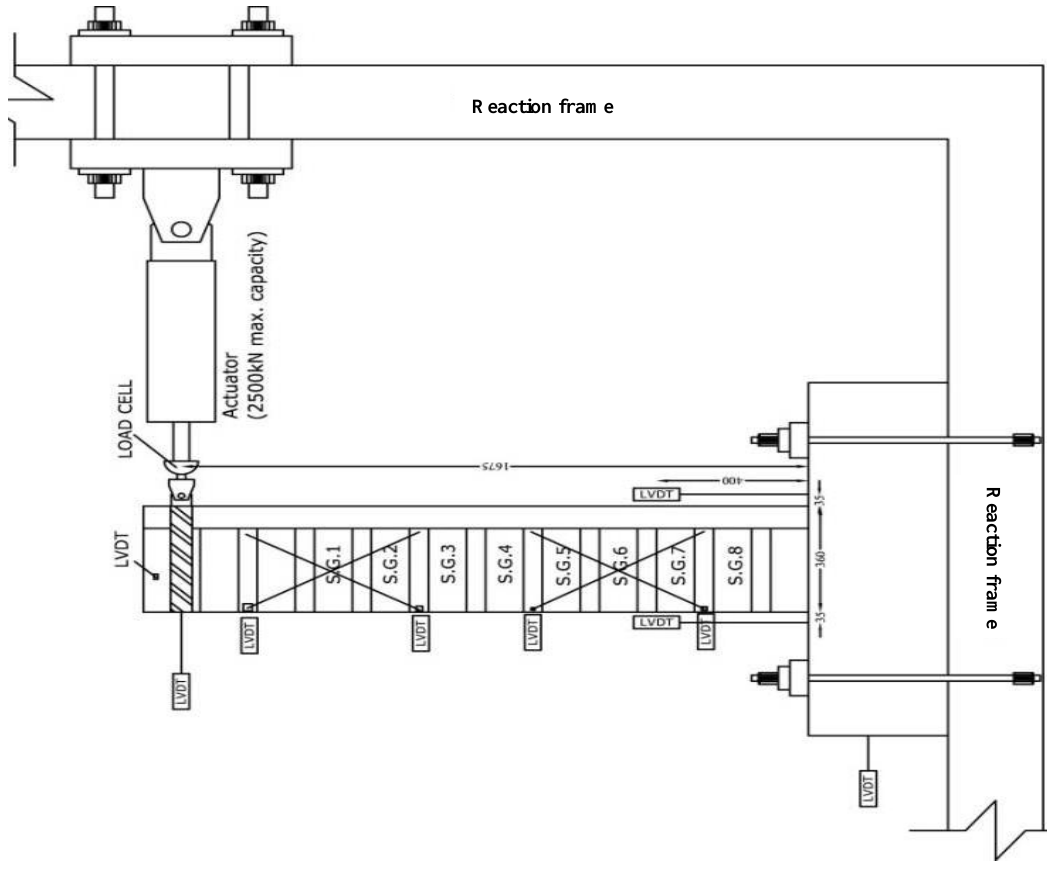
Figure 3. Experimental setup.